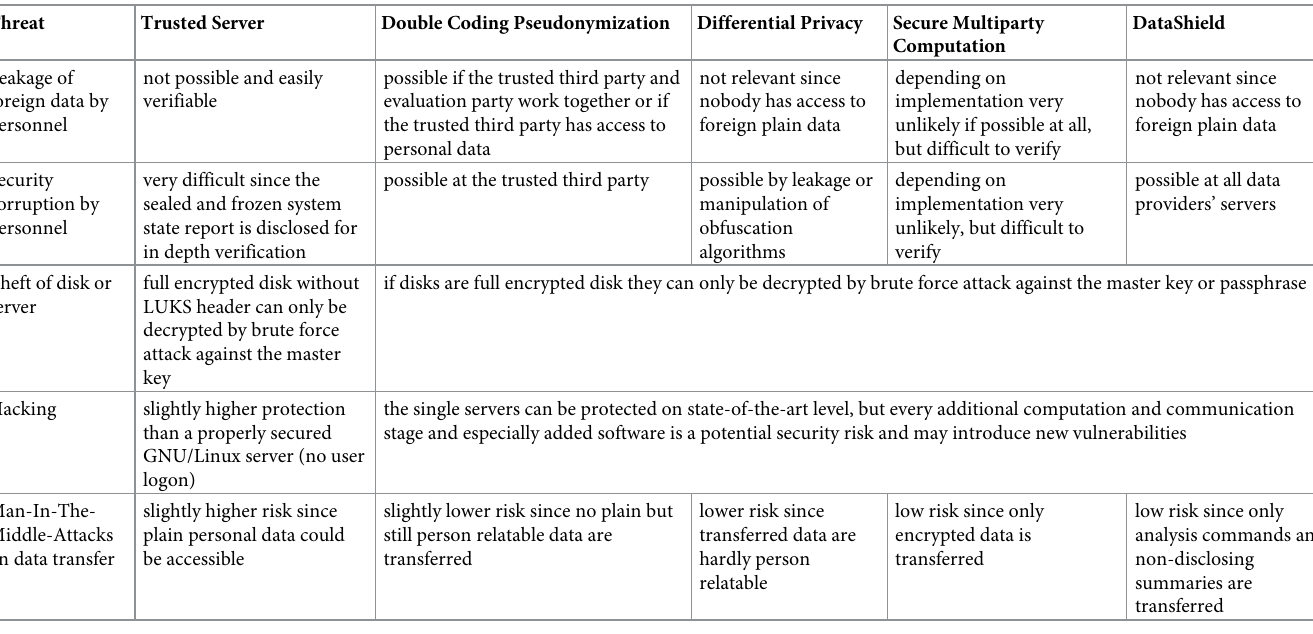
Table 3. Systematic risks for privacy and data security in different methods.